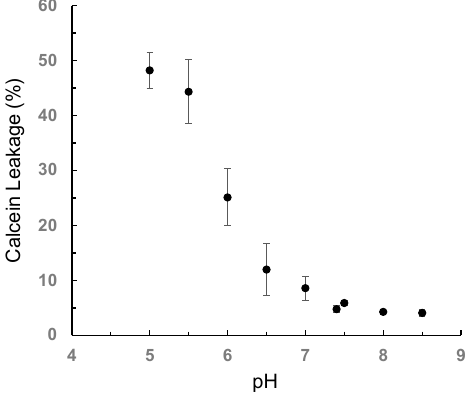
Figure 6. pH-dependence of the total amount of calcein release from liposomes anchoring the 1.0 mol% of rLPE-St. Error bars: SD of data from 5 measurements.